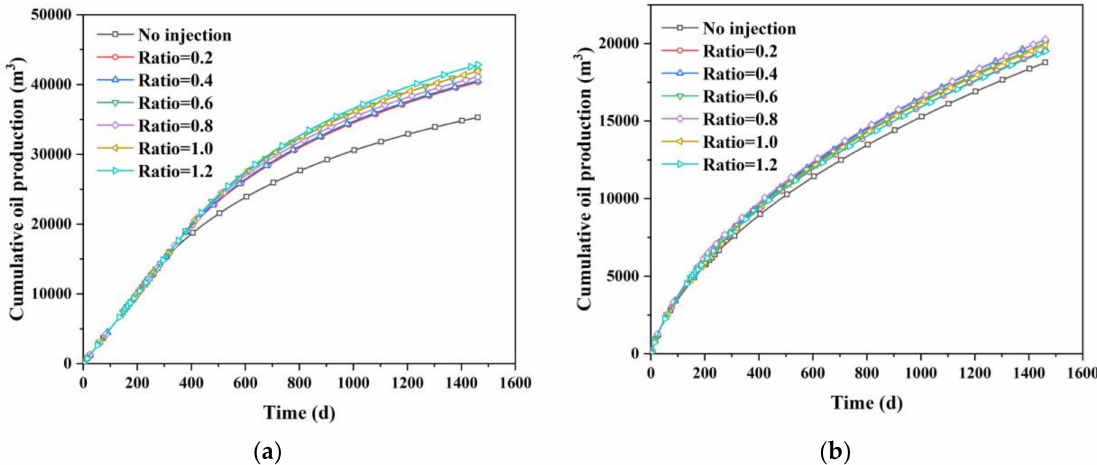
Figure 6. Cumulative oil production of different injection/production ratio, ( a ) parent well; ( b ) infill well.